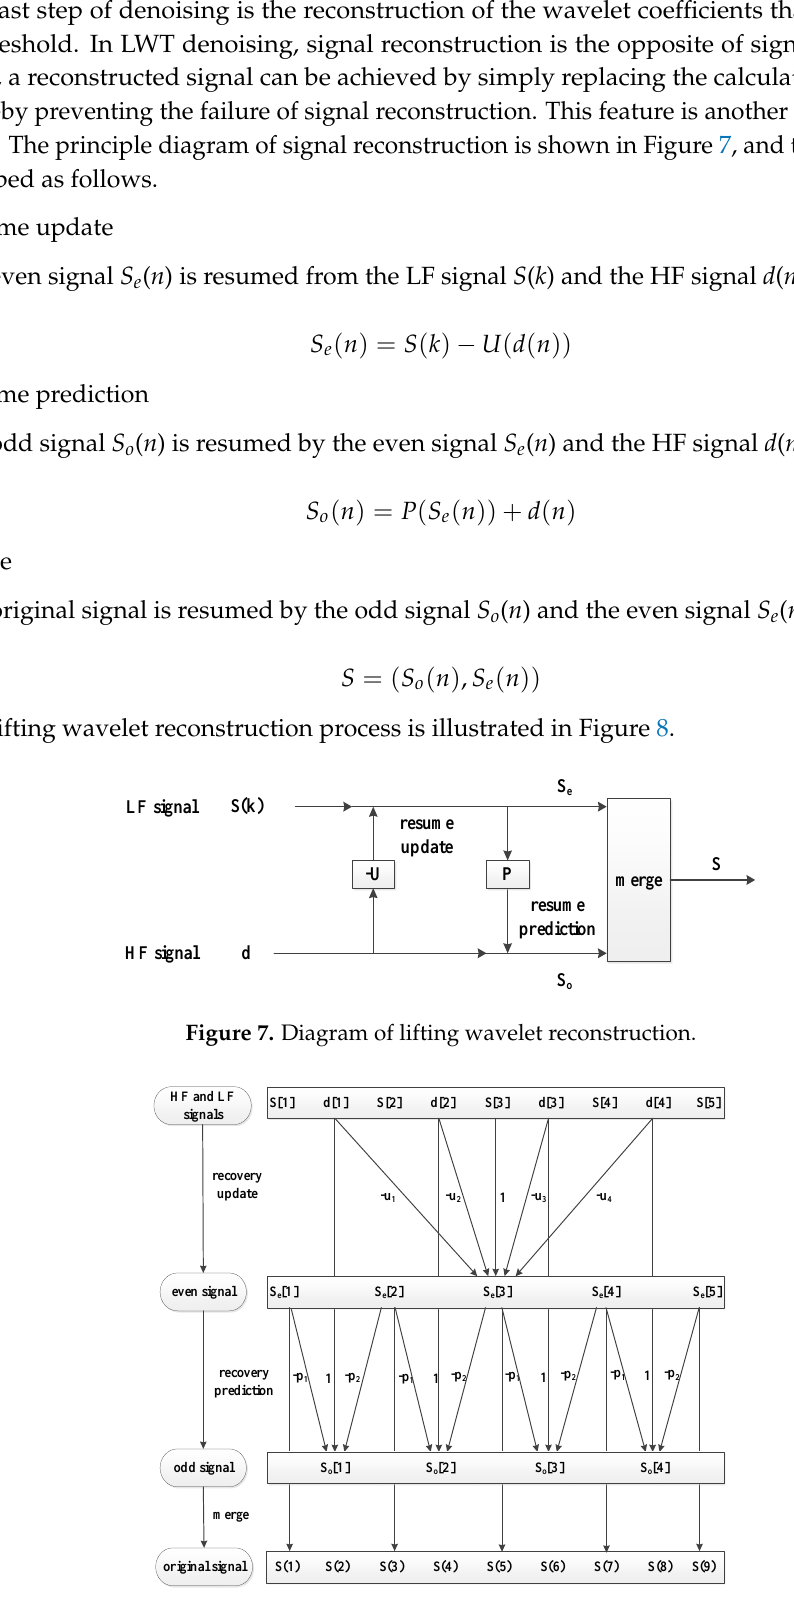
Figure 8. Rendering of lifting wavelet reconstruction.